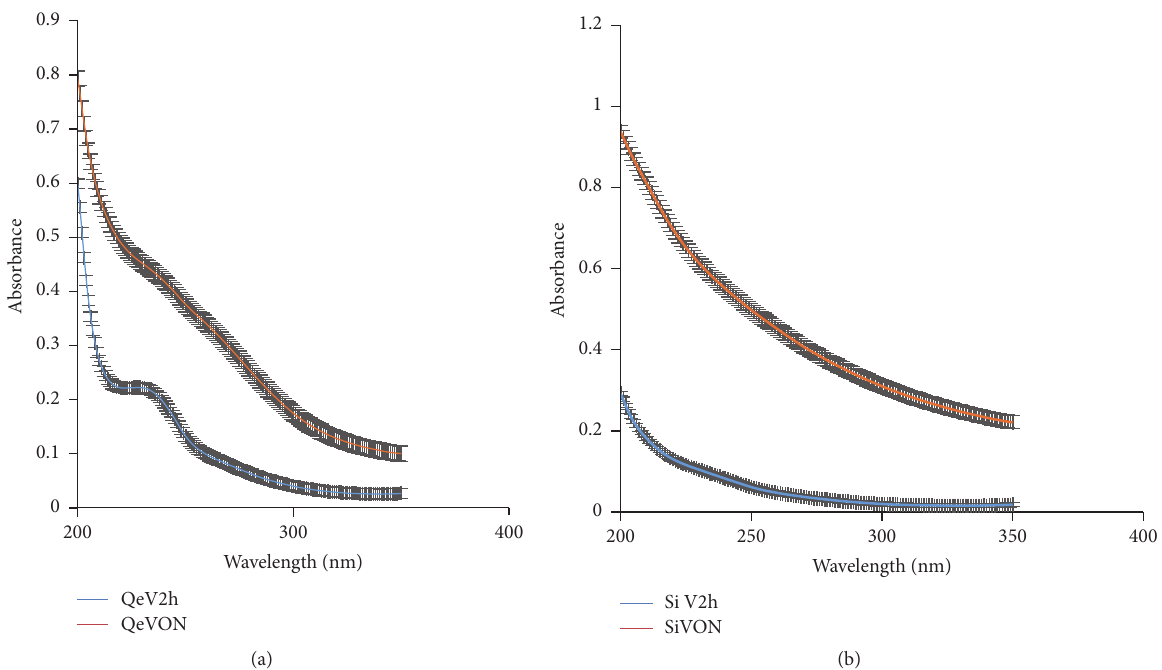
Figure 10: Representative absorption spectra of the QE-SUP (a) and Si-SUP (b) powder supernatants in DI water. Powder solutions were vortexed (2h or overnight) and centrifuged at room temperature. Supernatants were scanned for absorbance measurements between 350– 200